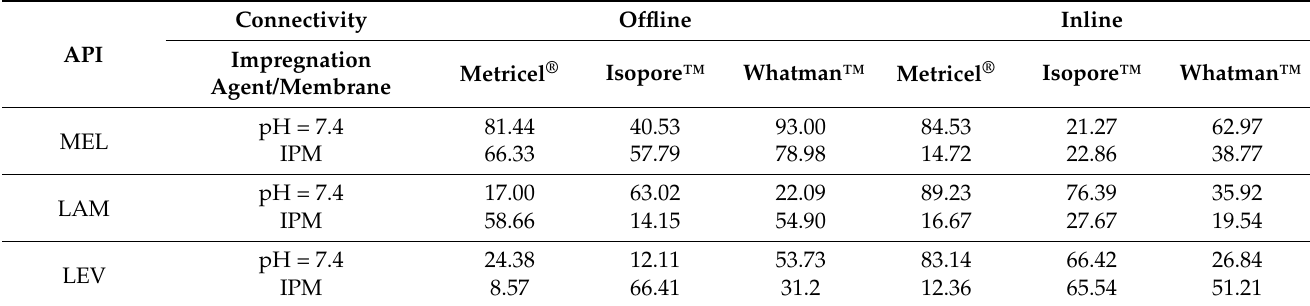
Table 7. Arithmetic mean (%) of the relative standard deviations of MEL, LAM, and LEV during the measurements.